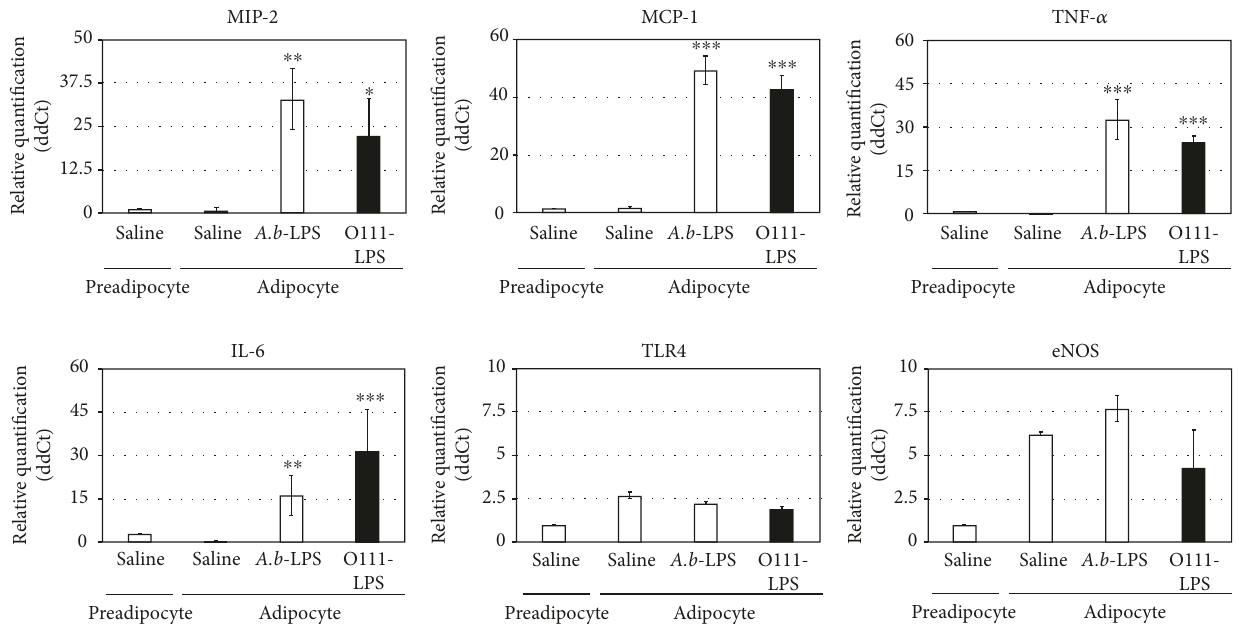
Figure 1: E ff ect of A. baumannii -LPS on adipokine expression including in fl ammatory cytokines and chemoattractants in 3T3-L1 adipocytes. Di ff erentiated adipocytes were incubated for 1h at 37 ° C with 100ng/mL A. baumannii -LPS (ATCC 19606), 100ng/mL E. coli - LPS (O111:B4), or saline and subjected to real-time PCR analyses to determine the mRNA expression levels of several adipokines, including MIP-2, TNF- α , IL-6, MCP-1, TLR4, and eNOS. Adipokine expression is presented as the ratio of viable cytokine expression in adipocytes treated with the di ff erent bacterial LPS versus the adipocytes treated with saline. All experiments were performed in triplicates, and the results are presented as the mean ± SD. ∗ P < 0 05 ; ∗∗ P < 0 01 ; ∗∗∗ P < 0 005 (compared to adipocytes without LPS